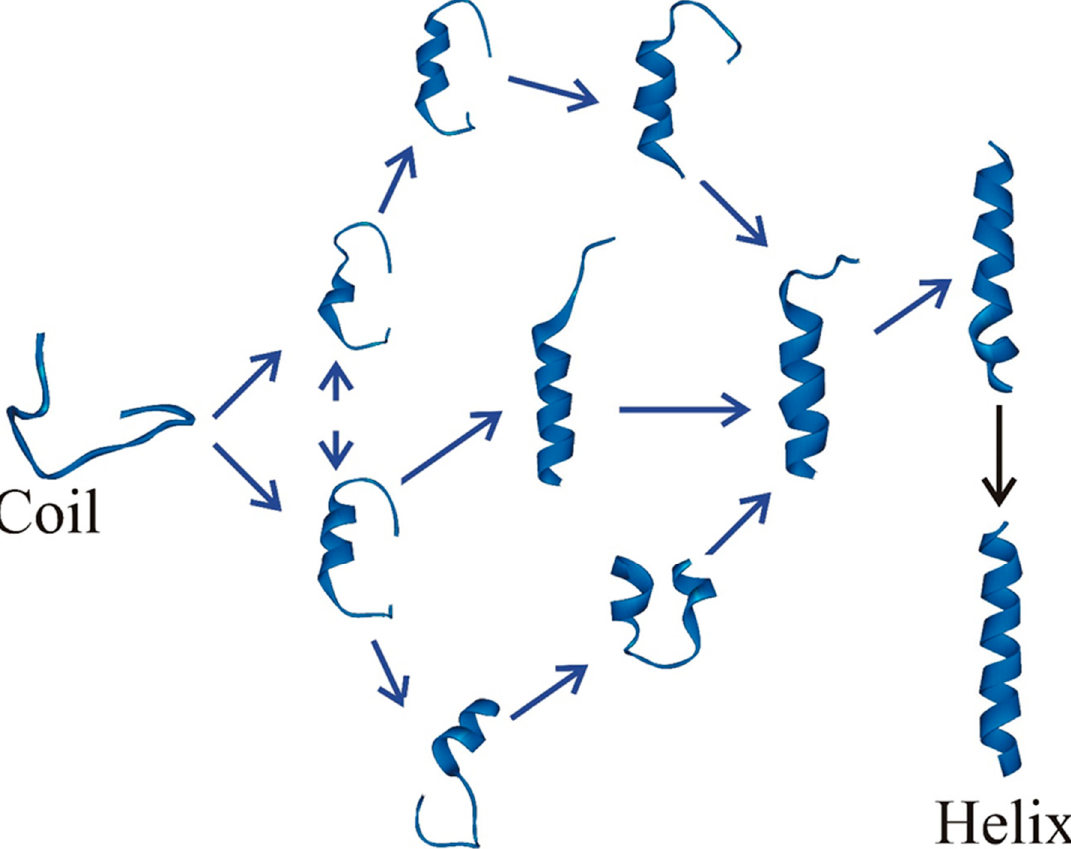
Figure 2. Schematic representation showing the progression pathways from the coil state to the helix state during helix–coil transition. The coil state is racing to reach the native helix state by assuming multiple conformations and coursing through various pathways. The coil state can become the helix state along the on-pathway through the formation of intermediates. It also has a high probability of reaching a helical conformation by following the off-pathway and visiting intermediates.